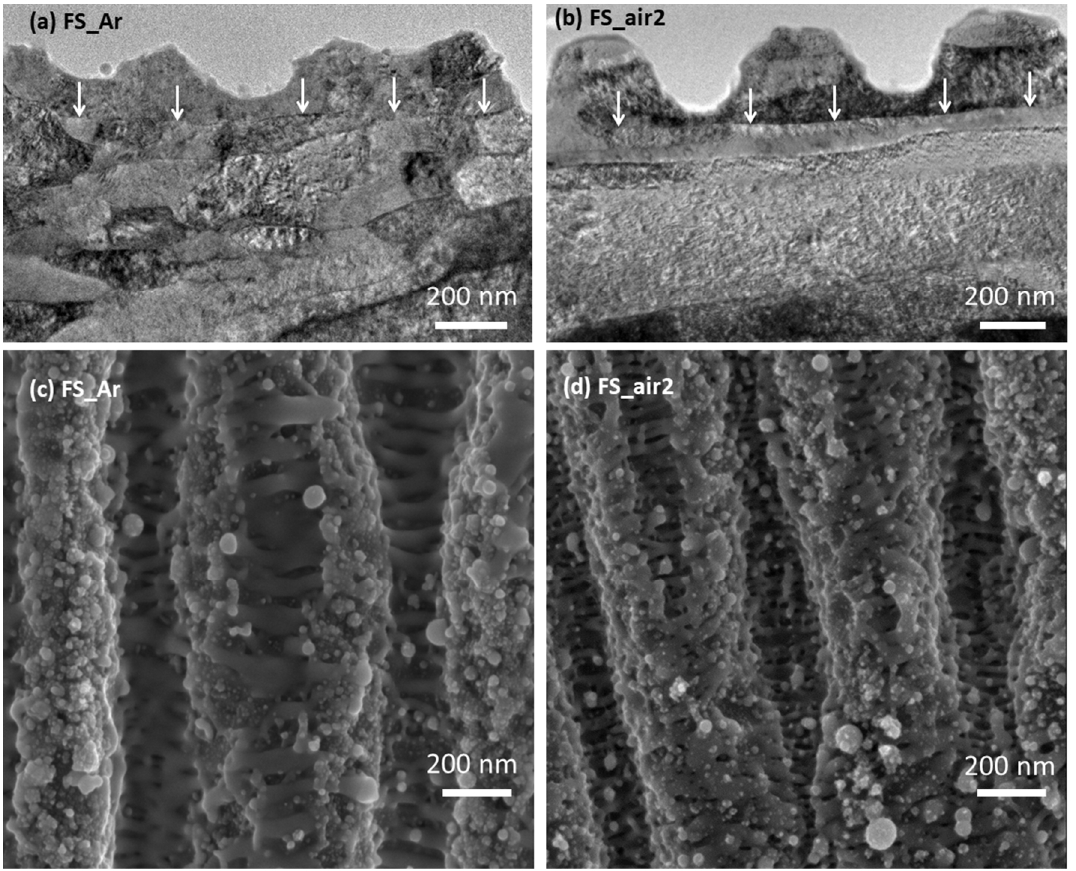
Figure 2. ( a , b ) STEM micrographs of the cross-sectional images near the surface. ( c , d ) FE-SEM top-view images (in-lens detector) of the surface of the same samples. (Left column) FS_Ar, (Right column) FS_air2. The white arrows in ( a , b ) point at the boundary between laser-affected and non-affected regions.